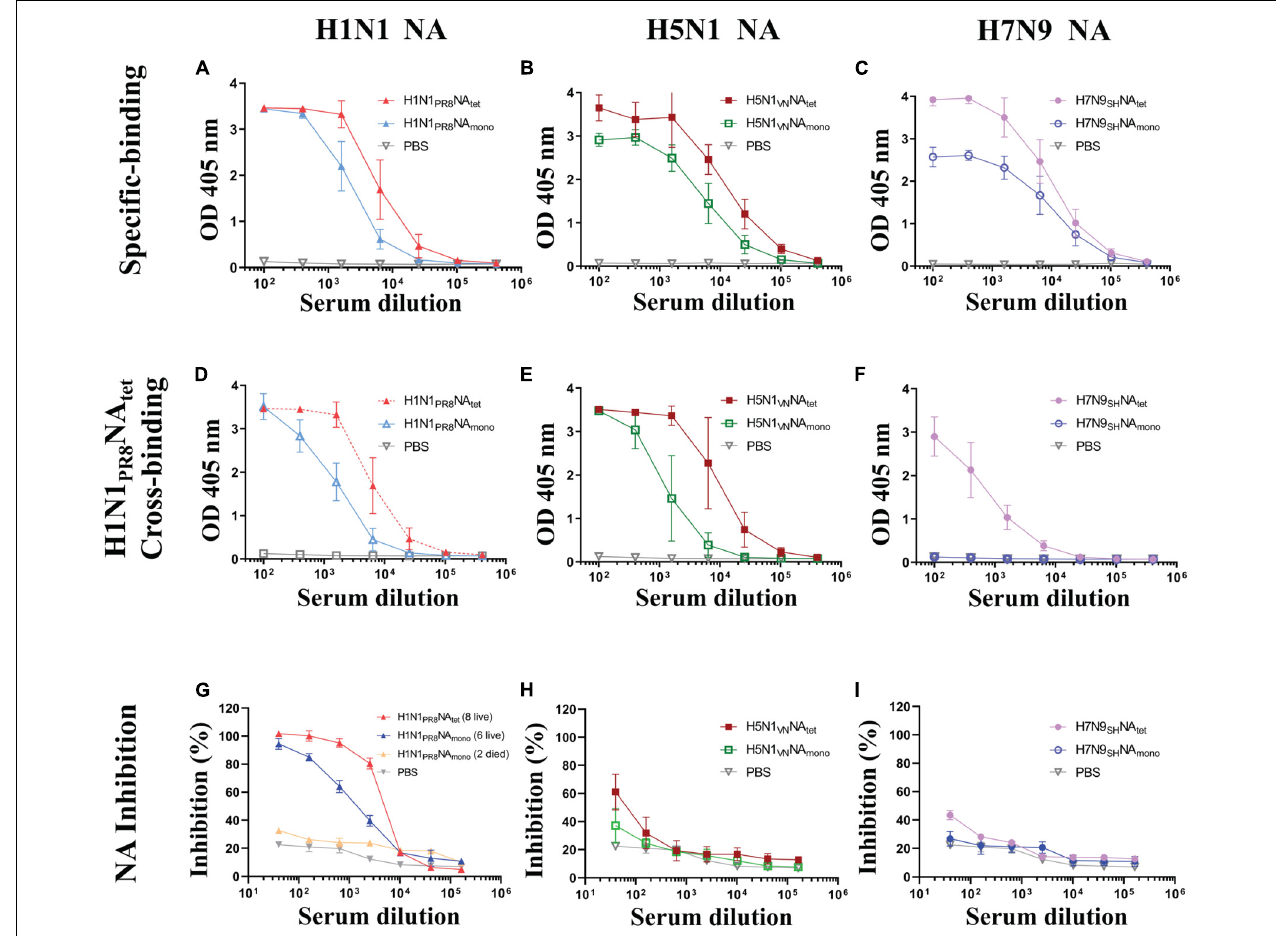
FIGURE 3 | Humoral response induced tetrameric and monomeric neuraminidase (NA) proteins. The experimental design for immunization and challenge studies was identical to that detailed in the legend of Figure 2A . Serum were collected at 1 week after the final immunization. (A–C) The sera of mice vaccinated, respectively, with H1N1 PR 8 NA tet and H1N1 PR 8 NA mono (A) , H5N1 VN NA tet and H5N1 VN NA mono (B) , and H7N9 SH NA tet and H7N9 SH NA mono (C) proteins were tested for NA-specific binding antibody levels to the respective immunogen via ELISA. (D–F) The same sera whose results are shown in panels (A–C) were tested for cross-binding activity to H1N1 PR 8 NA tet protein via ELISA, respectively. (G–I) The same sera mentioned above were tested for NA inhibition (NAI) activity against NA of A/PR8 (H1N1) via enzyme-linked lectin assay (ELLA),